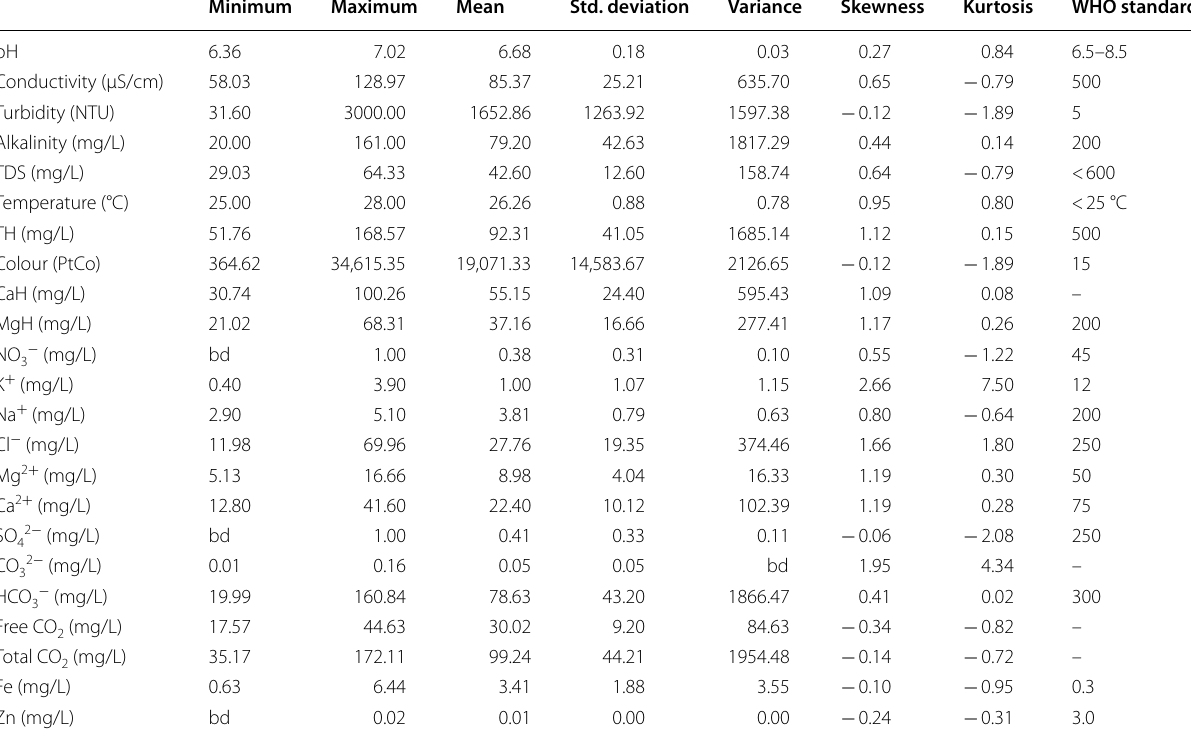
Table 3 Physicochemical parameter of surface water samples collected from settlements within the Birim River